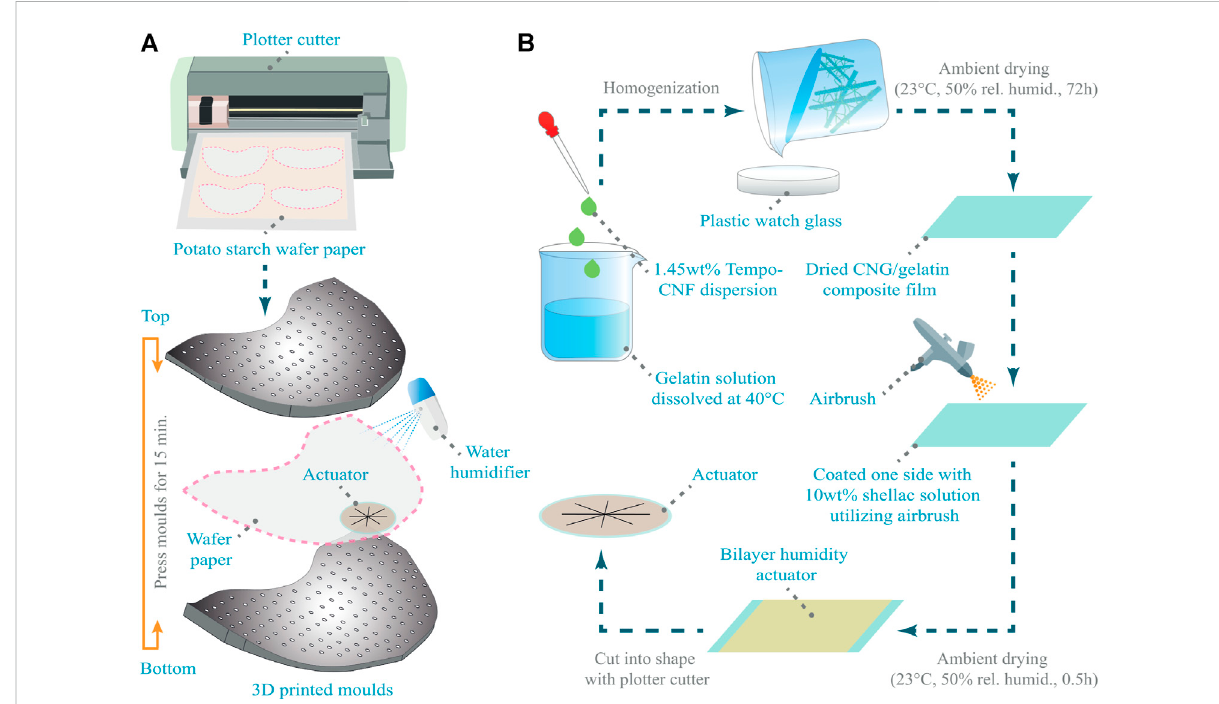
FIGURE 2 Manufacturing fl owcharts of the glider and actuators. (A) The potato paper is cut using a plotter cutter. Afterwards the fl at template is wetted, pressed into a 3D shape using a 3D printed mold and the actuator is bonded to the air-frame, (B) After the TEMPO-CNF dispersion is homogenized withtheGelatinsolution,themixtureispouredonaglassplateanddriedinambientconditions.Thedried fi lmsarethenmanuallycoatedwith10wt% shellac solution. After drying the actuators are cut into the desired